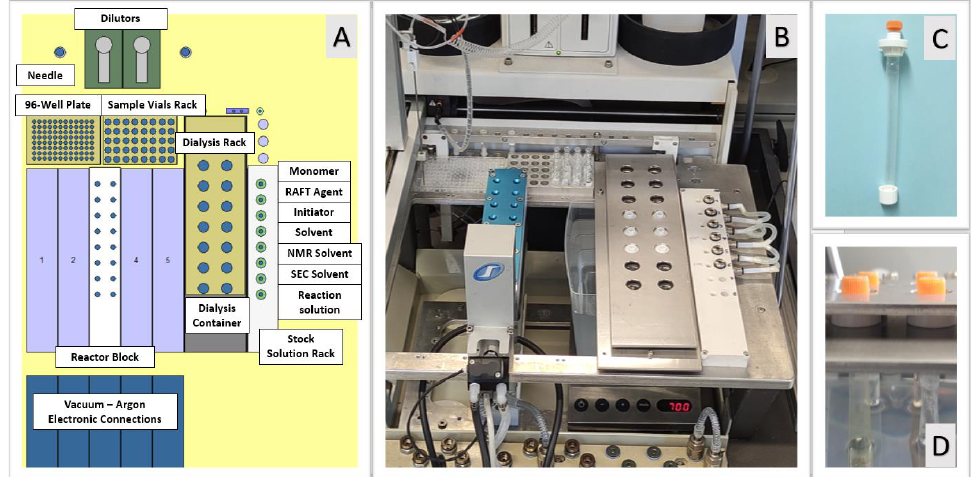
Figure 2. ( A ) Schematic representation of ASW2000 APS adapted with the APD system. Overviews of: ( B ) ASW2000 APS adapted with the APD system, ( C ) dialysis tubes used for the APD system, and ( D ) customized rack holding the dialysis tubes in the dialysis container.